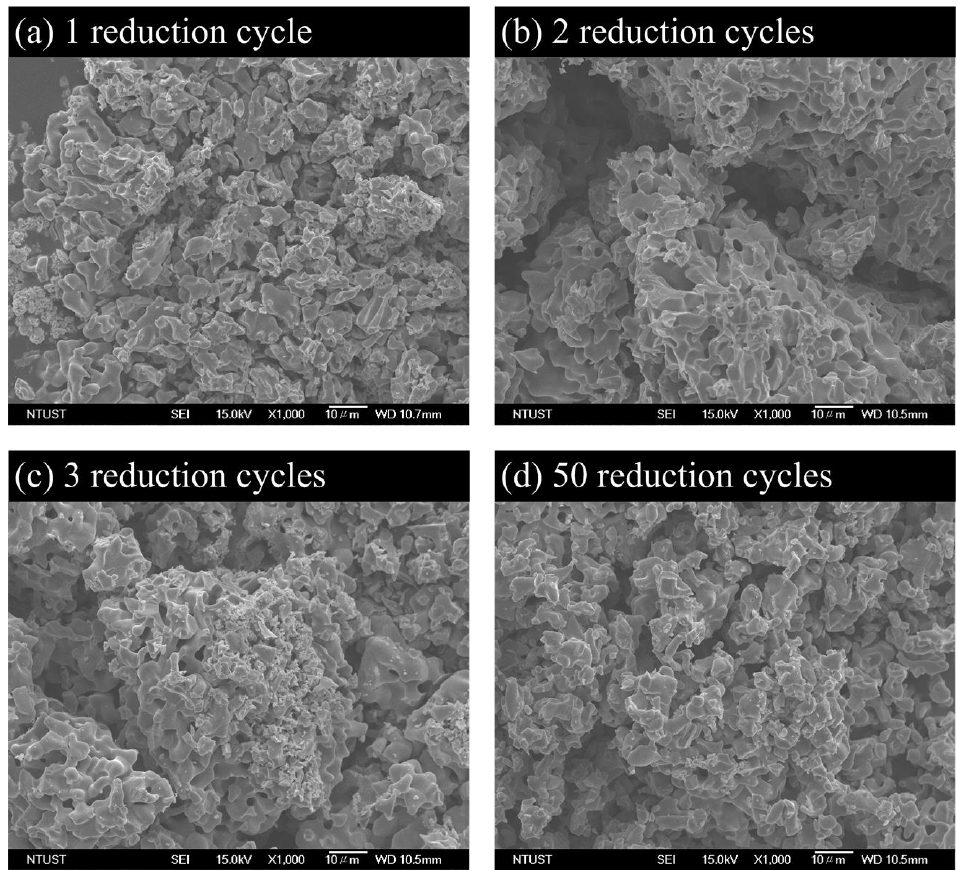
Figure 3. SEM images of CuO oxygen carriers after 1, 2, 3, 10, and 50 redox cycles under nitrogen atmosphere at 950 °C.